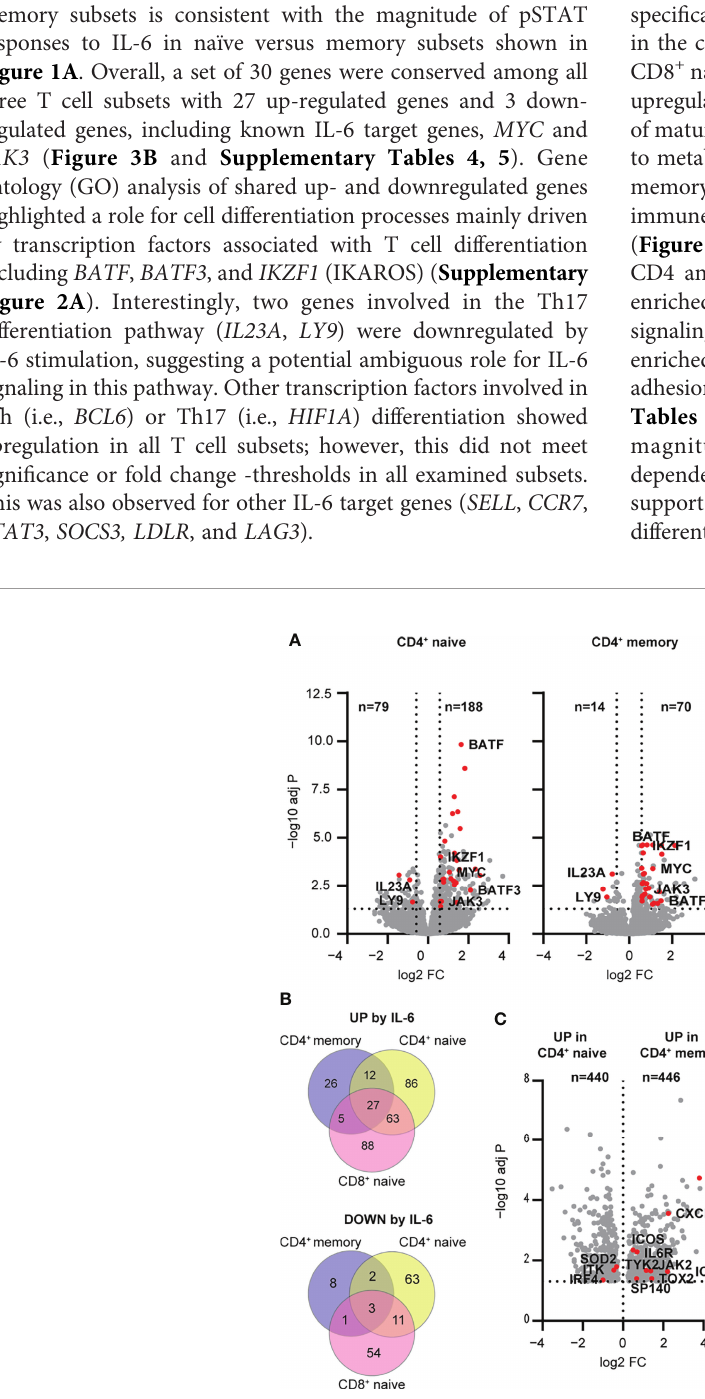
FIGURE 3 | Early transcriptomic response to IL-6 stimulation highlights pathways regulated by mbIL-6R signaling in human T cell subsets. (A-C) Transcriptome pro fi ling of total CD4 + naïve, memory, and CD8 + naïve T cell subsets stimulated with IL-6 (20 ng/mL) or left unstimulated for 4 h was performed using RNA-seq. (A) Volcano plots showing differentially expressed genes between IL-6 stimulated versus unstimulated T cells. Shared up- and downregulated genes between subsets are highlighted (red). (B) Venn diagram of IL-6 up- (top) or downregulated (bottom) genes unique to or shared between T cell subsets. (C) Genes upregulated following IL-6 stimulation but not at baseline comparing CD4 + naïve versus memory or CD4 + naïve versus CD8 + naïve T cells. (A, B) FC > 1.5, FDR adj. P < 0.05. (C) FDR adj. P < 0.05. n =